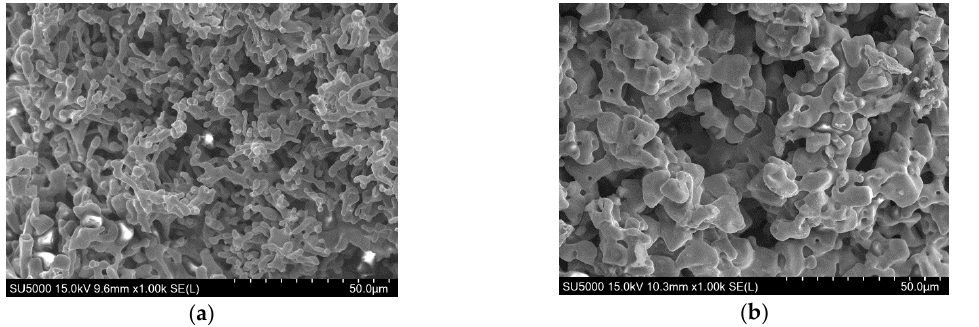
Figure 3. Microstructure of reduced briquettes with different dosage of borax by scanning electron microscope (SEM) (( a ): 0% borax, ( b ): 5% borax).